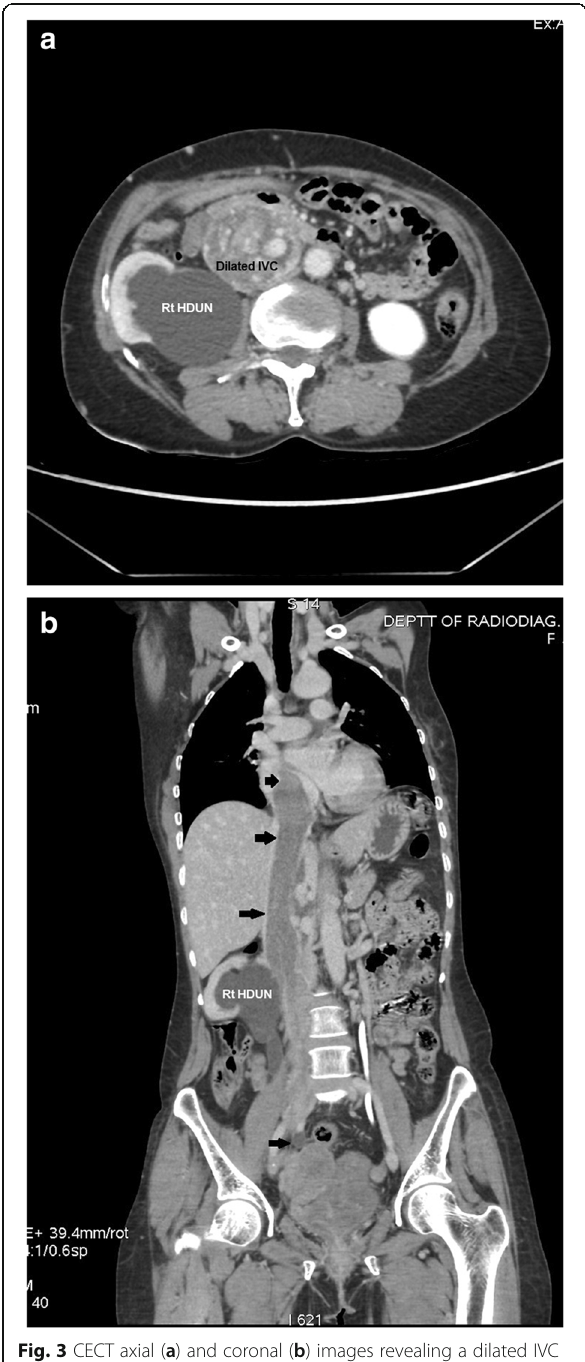
Fig. 3 CECT axial ( a ) and coronal ( b ) images revealing a dilated IVC (arrows) extending into the right ventricle. Dilated IVC compressed upon rt. ureter to cause rt. hydroureteronephrosis (Rt